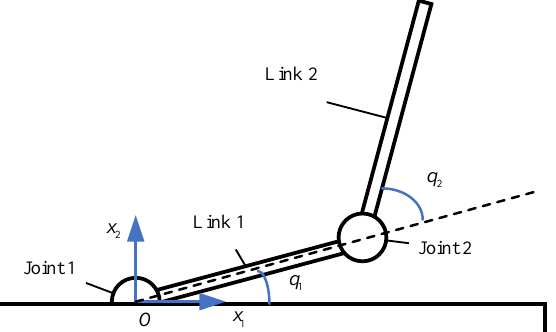
Figure 4. The simulated robot was selected as a two-link robot. The joint angles are, respectively, q 1 and q 2